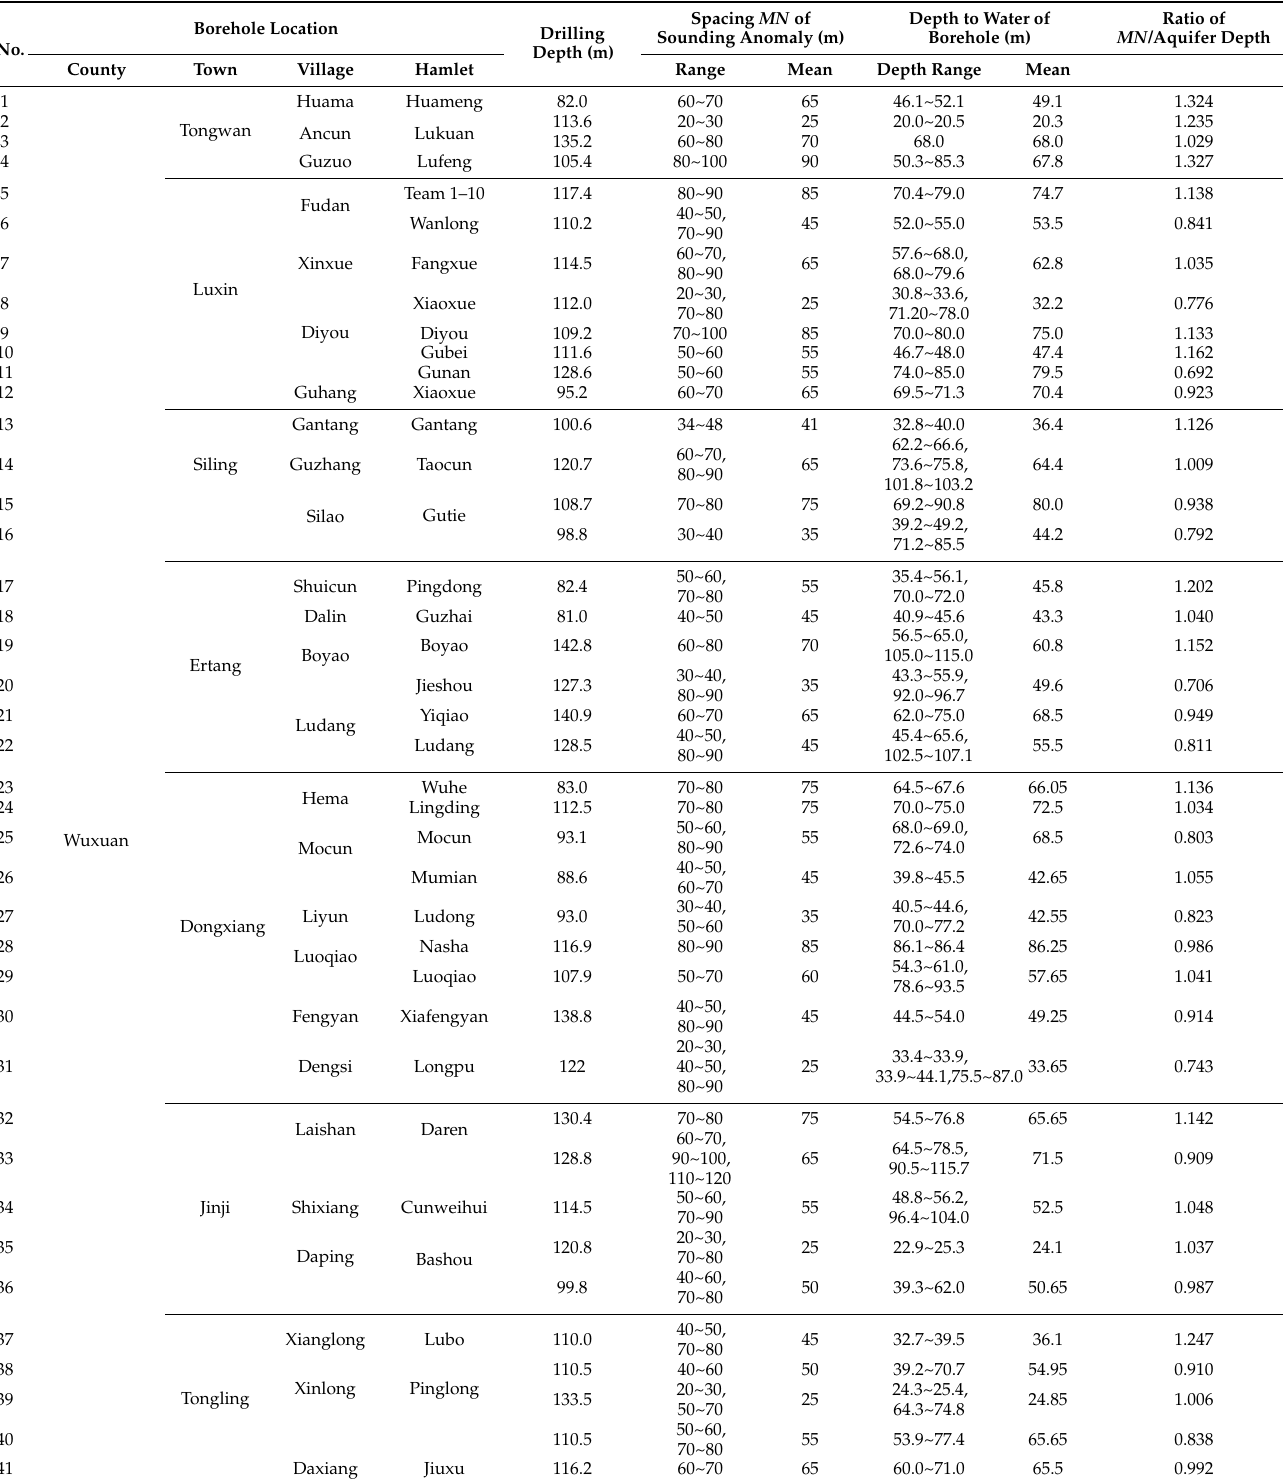
Table 1. The detail of some typical borehole